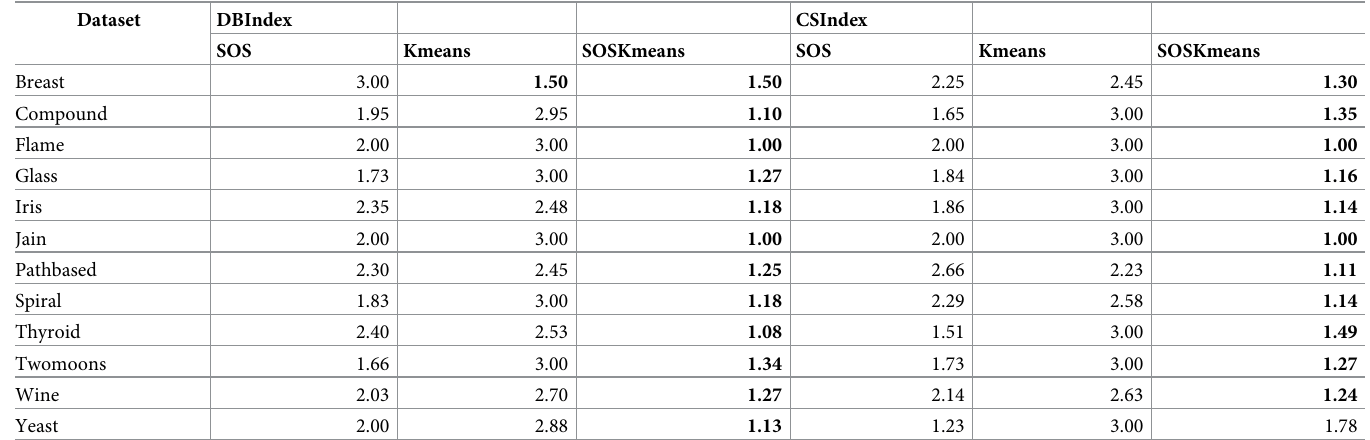
Table 8. The Friedman means rank test results for the SOS, K-means and hybrid SOSK-means algorithms. Dataset